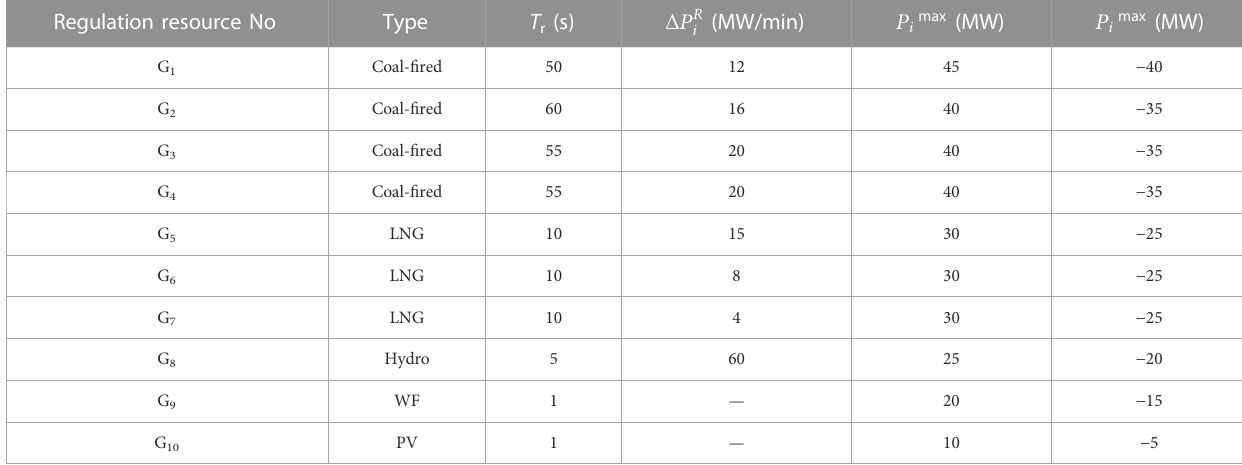
TABLE 2 Main parameters of the dispatch regulation resources in the DT-DPT system. Regulation resource No